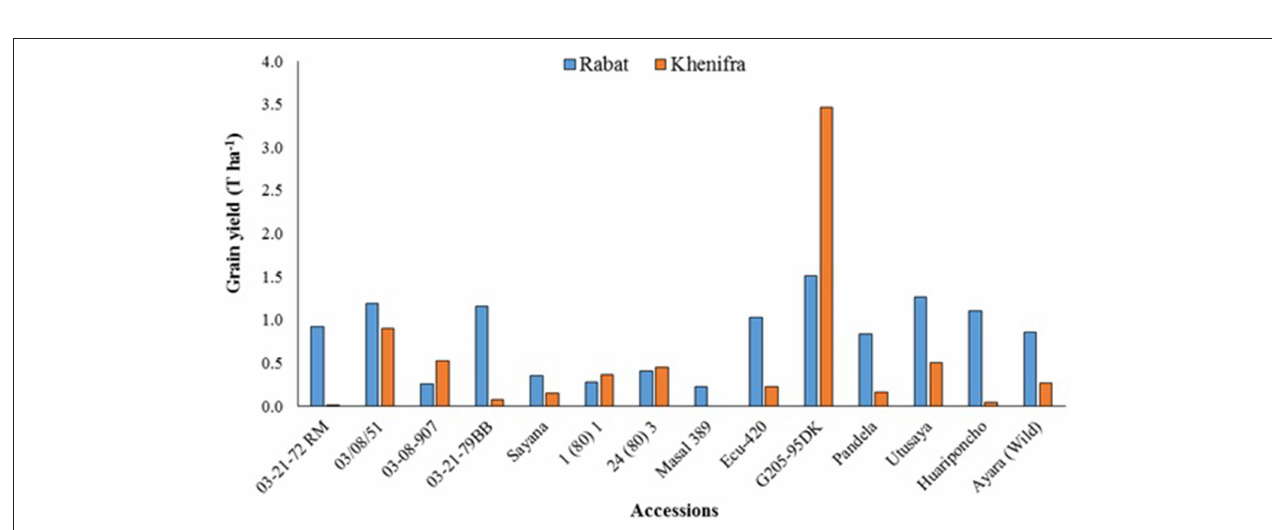
FIGURE 2 | The mean seed yields of five quinoa lines grown at four locations in Central Asia. The error bars represent standard errors of the means (ICBA, 2015 ).